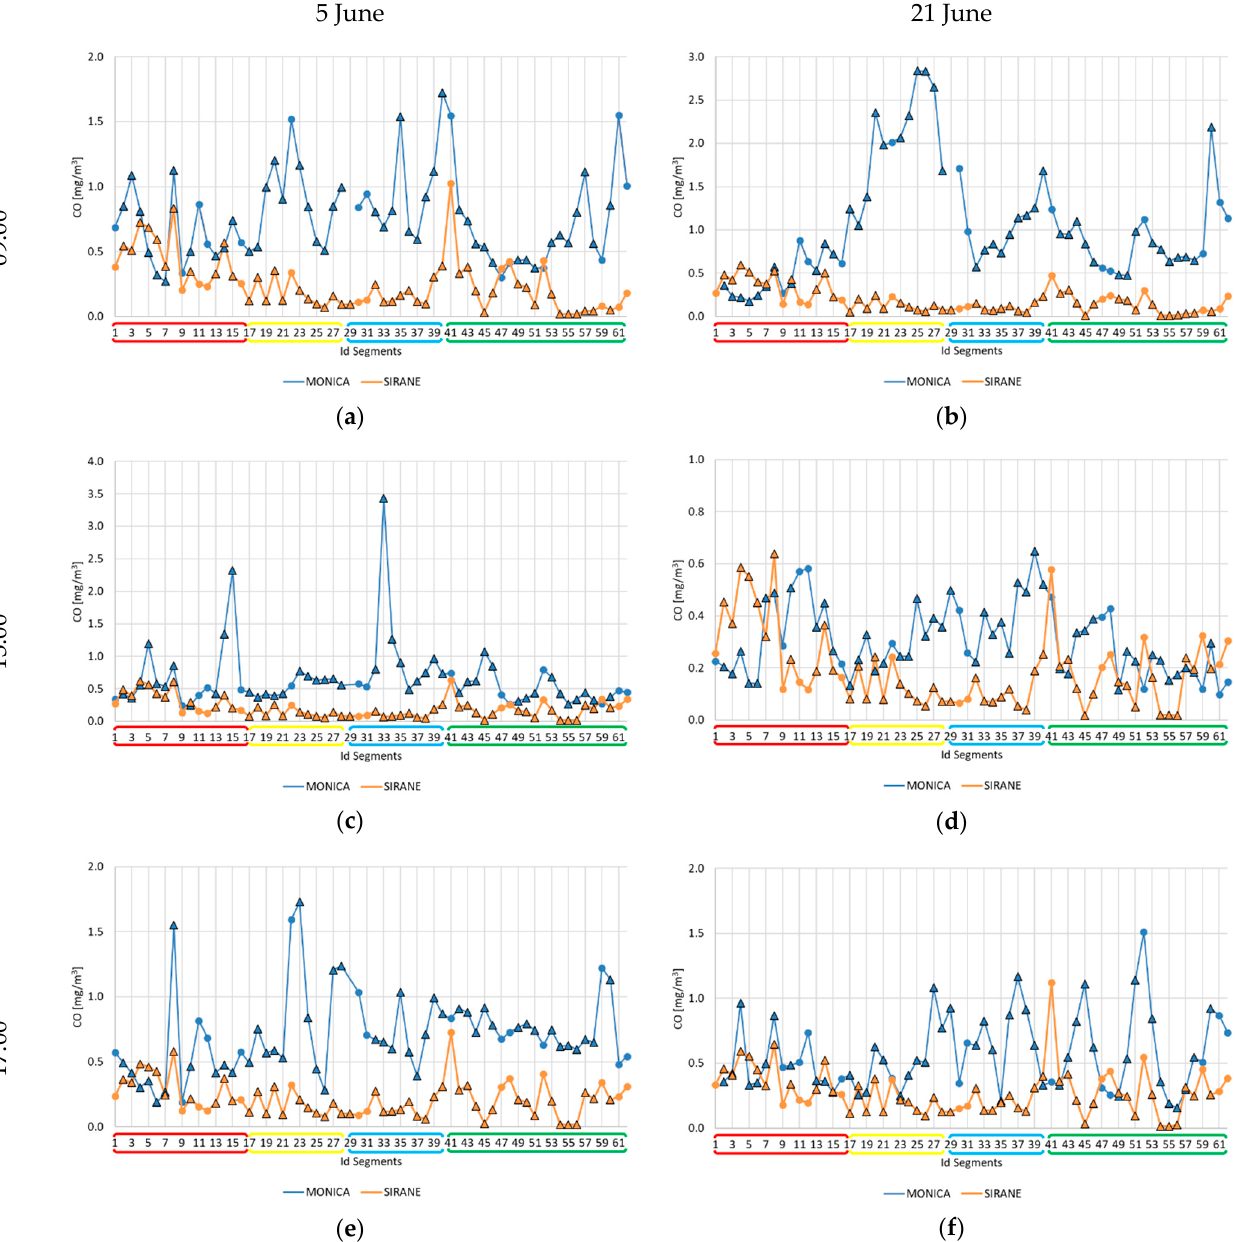
Figure 9. Comparison between MONICA (blue line) and SIRANE (orange line), for CO pollutant: ( a ) at 9 am on 5 June; ( b ) at 9 am on 21 June; ( c ) at 1 am on 5 June; ( d ) at 1 am on 21 June; ( e ) at 5 pm on 5 June; ( f ) at 5 pm on 21 June. Triangles are street canyons and circle open roads. The ID receptors from 1 to 16 (red lines) are referred to the road segment Corso Garibaildi; IDs from 17 to 28 (yellow lines) to the road segment Via Libertà ; IDs from 29 to 40 (blue lines) to the road segment Via DaVinci; IDs from 41 to 61 (green lines) to the road segment Via Diaz.